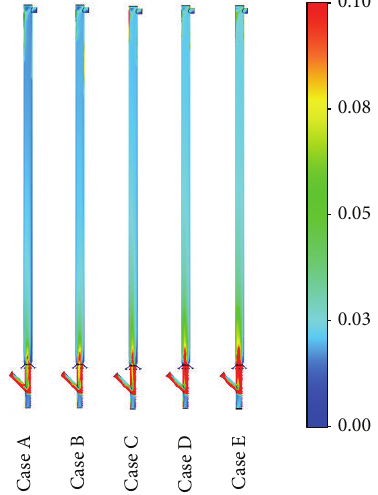
Figure 14: Products yields for each catalyst temperature.